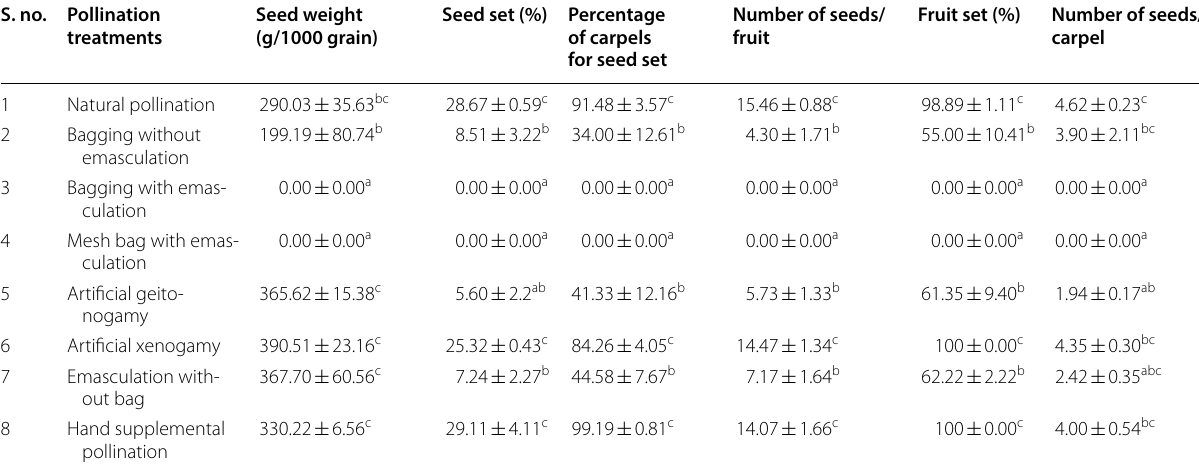
SE) on several traits in P. decomposita ±